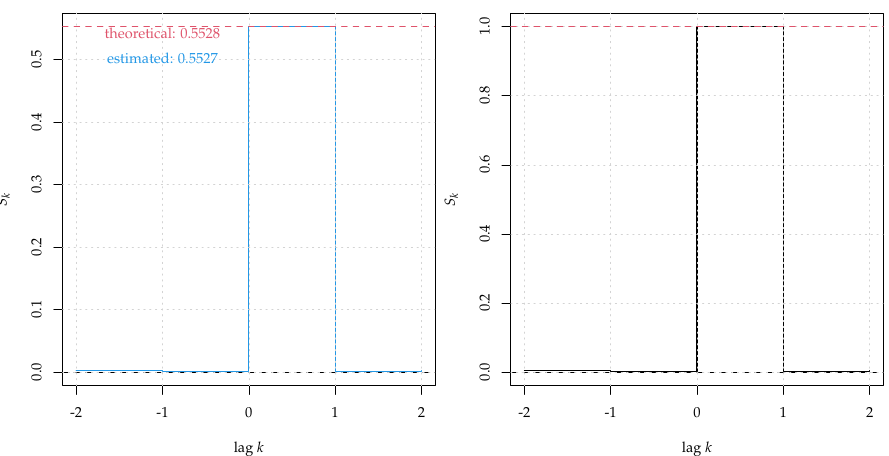
Figure 4. Cross Entropy S k for categorical data, in the presence of perfect dependence at lag 1. The left panel shows the unnormalized measure (blue, solid line), where the maximum attainable level is indicated in red. The right panel shows the normalized version of the measure (black, solid